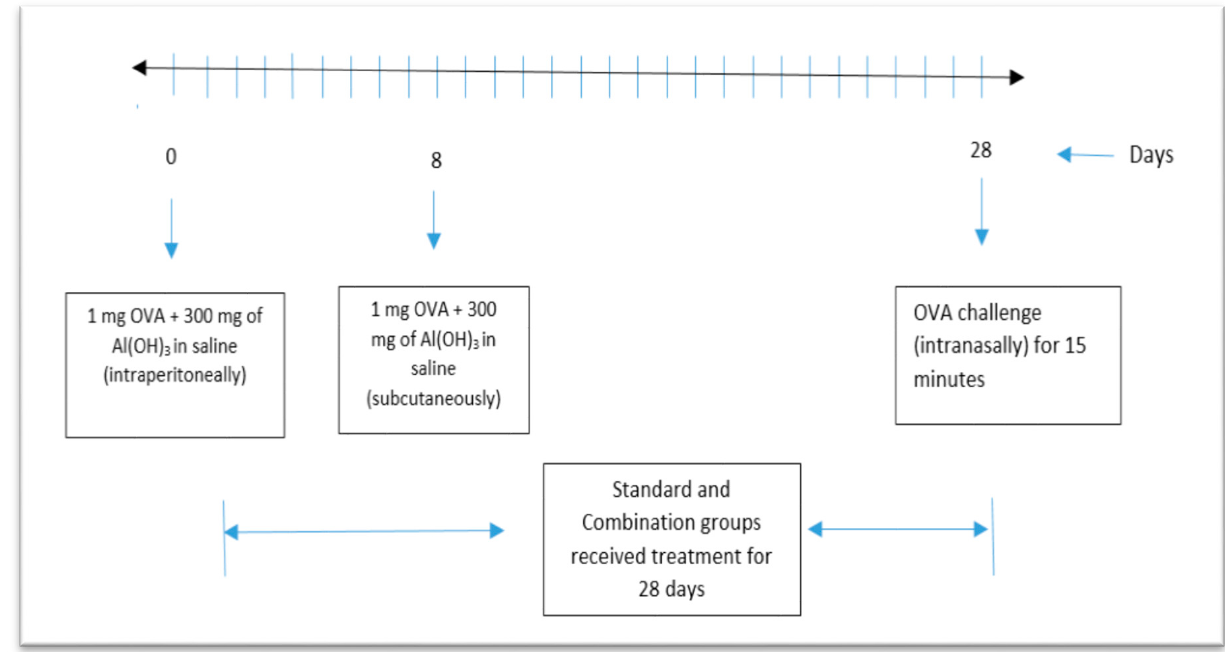
Figure 1. Timeline of the study.